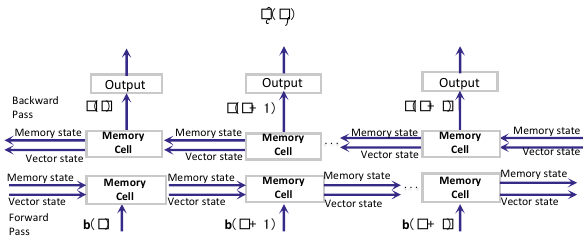
Figure 6. The architecture of a bi-directional neural network model used for estimating the space coordinates for the distrortion of the bluetooth signals 𝑏 (cid:3036) (𝑡)